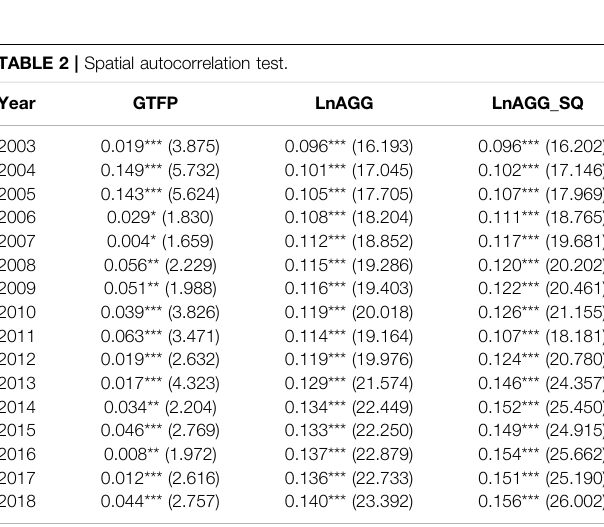
FIGURE 2 | Spatial variation of the GTFP and AGG .